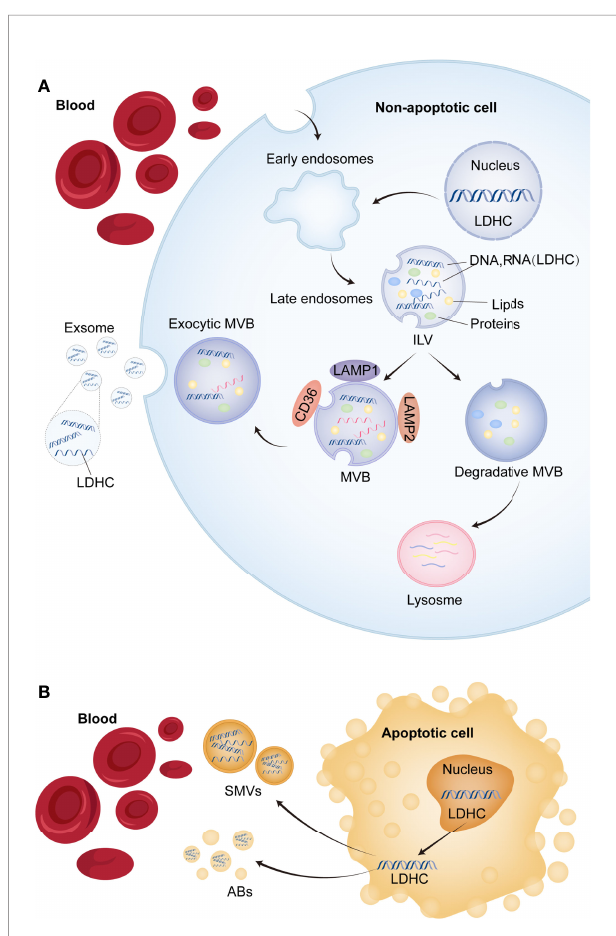
FIGURE 6 | The potential mechanism of exosomal LDHC secretion into the circulation. (A) The process of releasing exosomes and shed microvesicles (SMVs) (including LDHC molecule) into the circulation. Early endosomal contents (proteins and nucleic acids) either circulate into the plasma membrane (PM) or are isolated in intraluminal vesicles (ILVs), which are produced by limiting membrane germination into the lumen of the larger multivesicular body (MVB). (B) Apoptotic or non-apoptotic death of tumor cells will also result in the production of apoptotic bodies (ABs). Microbubbles fall off from foamed PM or are released from apoptotic tumor cells. These vesicles are remnants of degraded apoptotic cells and contain nuclear and cytoplasmic components ( LDHC molecule